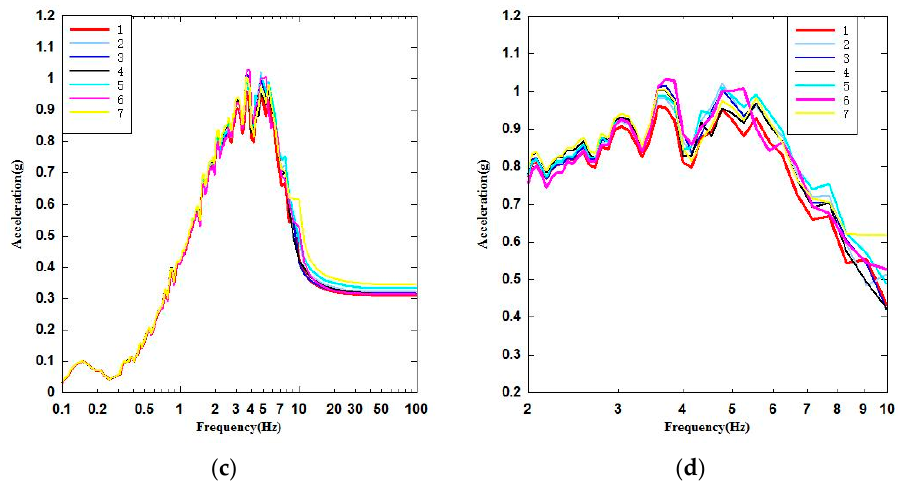
Figure 11. Peak acceleration and floor response spectrum of the raft foundation at 7 positions in the y direction. ( a ) Acceleration time history of the raft foundation in the y direction. ( b ) Peak acceleration of the raft foundation in the y direction. ( c ) Floor response spectrum of the raft foundation in the y direction. ( d ) Floor response spectrum of the raft foundation in the y direction (2–10 Hz).